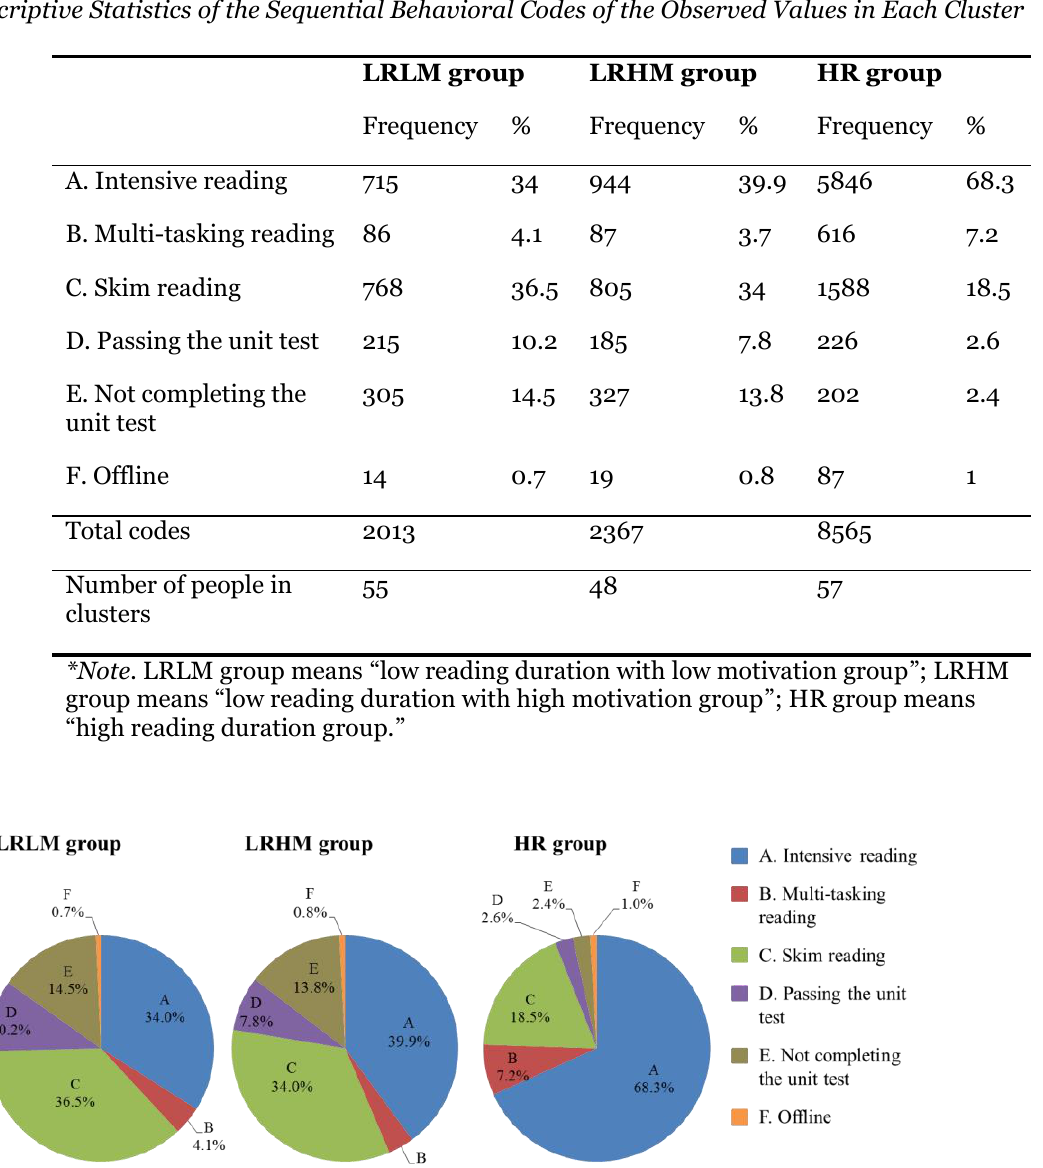
Descriptive Statistics of the Sequential Behavioral Codes of the Observed Values in Each Cluster